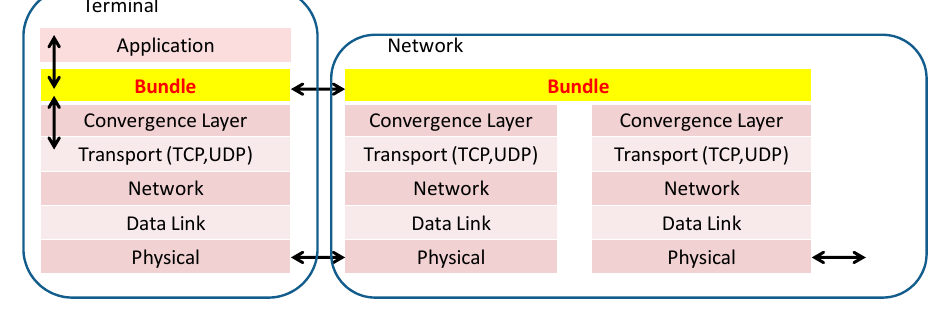
Figure 2. Protocol stack structure for communication in a DTN.